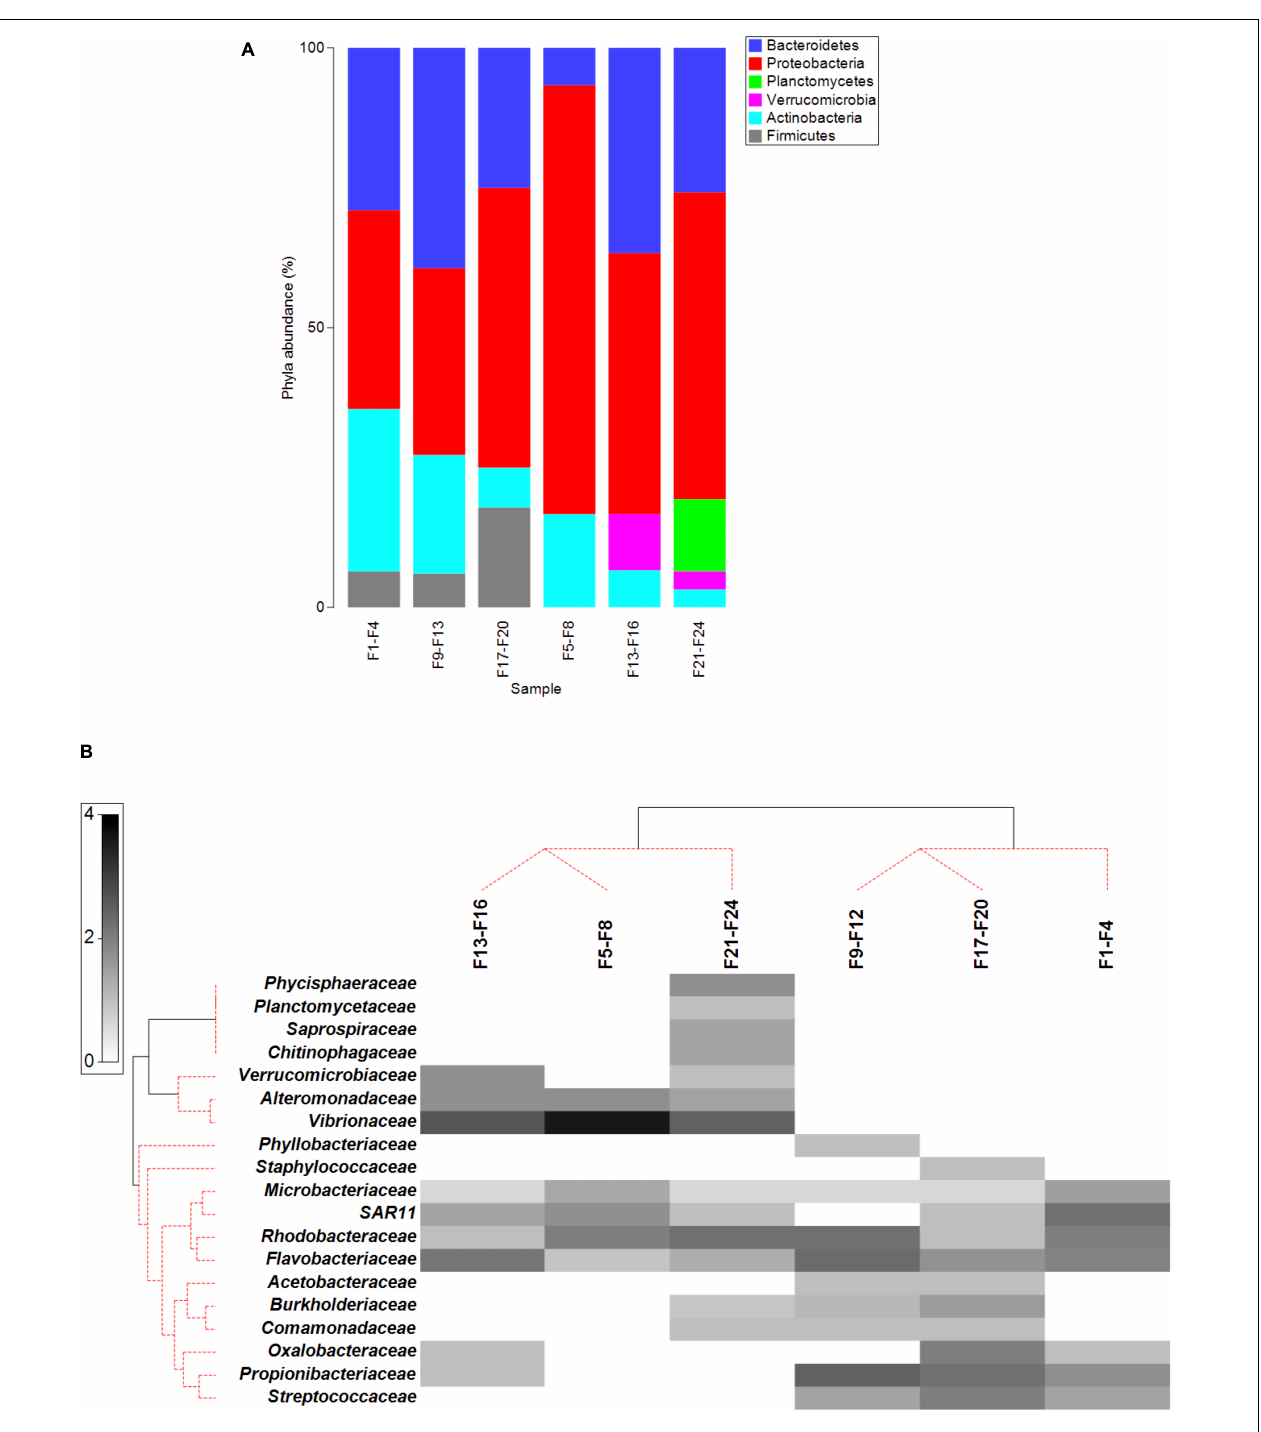
FIGURE 1 | (A) Phyla abundance (%) in the microbiota of the intestinal fluid of Sparus aurata at 400 µ atm CO 2 (F1–F4, F9–F12, F17–F20) and at 1200 µ atm CO 2 (F5–F8, F13–F16, F21–F24). (B) Shade plot of abundance of the 19 OTUs (in the rows; Family level) identified in the six samples (in the columns) of S. aurata intestinal fluid. White space denotes absence of that OUT in that sample. Depth of gray scale is linearly proportional to a square-root transformation of abundance. The same transform was used for sample clustering and for OUT clustering. Samples were grouped using Bray–Curtis similarities on the transformed data, by hierarchical, unconstrained divisive clustering (UNCTREE), together with Type I SIMPROF tests. Two separated groups of samples (continuous lines), corresponding to the two CO 2 levels under study, were supported by the SIMPROF test (significance level 5%). OTUs were also clustered, with the standard agglomerative method (group average linked), based on index of association resemblances computed on the transformed data, together with level Type 3 SIMPROF tests. Three coherent groups (continuous lines; cophenetic correlation: 0.86) were supported by the SIMPROF test (significance level 5%).